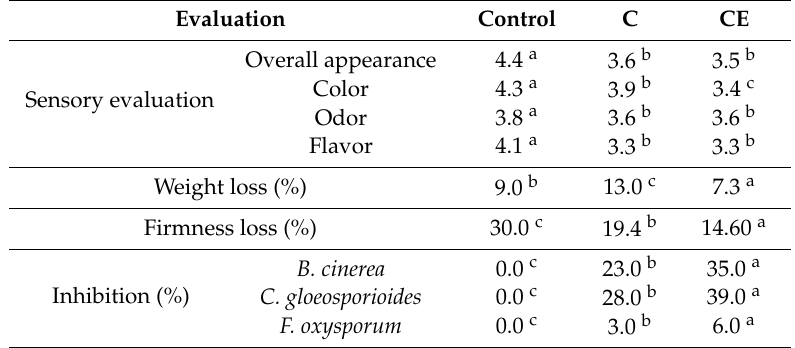
Table 2. Sensory evaluation, weight loss, firmness loss, and antifungal activity of edible